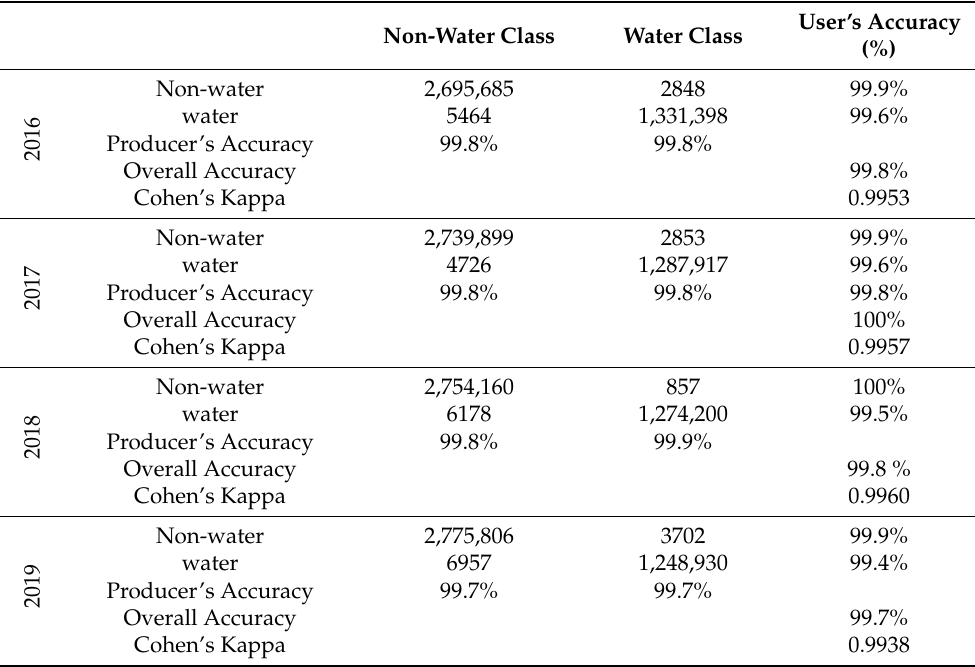
Table 1. Accuracy assessment of the last 4 years of the Burdur NDWI area (2016, 2017, 2018, and 2019) based on the visual interpretation from Sentinel-2 images using the pixel-by-pixel method. User’s Accuracy Non-Water Class Water Class